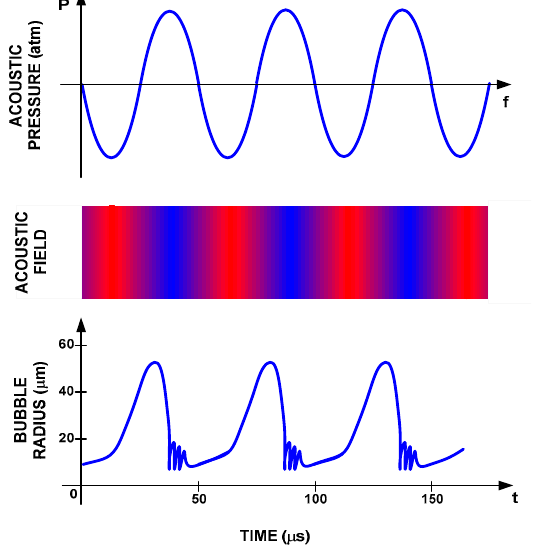
Figure 7. Formation and collapse of bubbles in a transitory state.